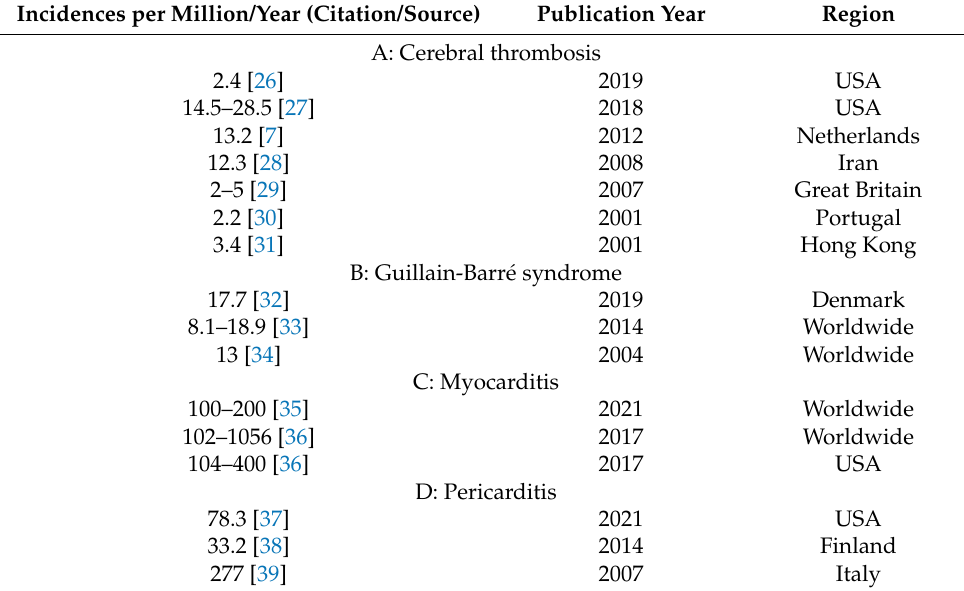
Table 1. Evaluation of incidence rates for CVST, GBS, myocarditis, and pericarditis in the general population, either regionally or globally depending on the available data. References for the stated incidence rates are included in